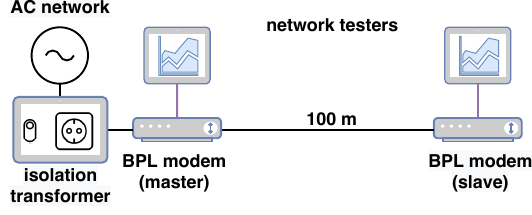
Figure 3. A1 topology—direct connection.